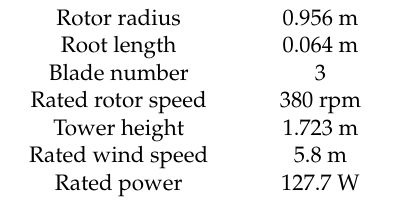
Table 1. Specifications of the wind turbine scale model.